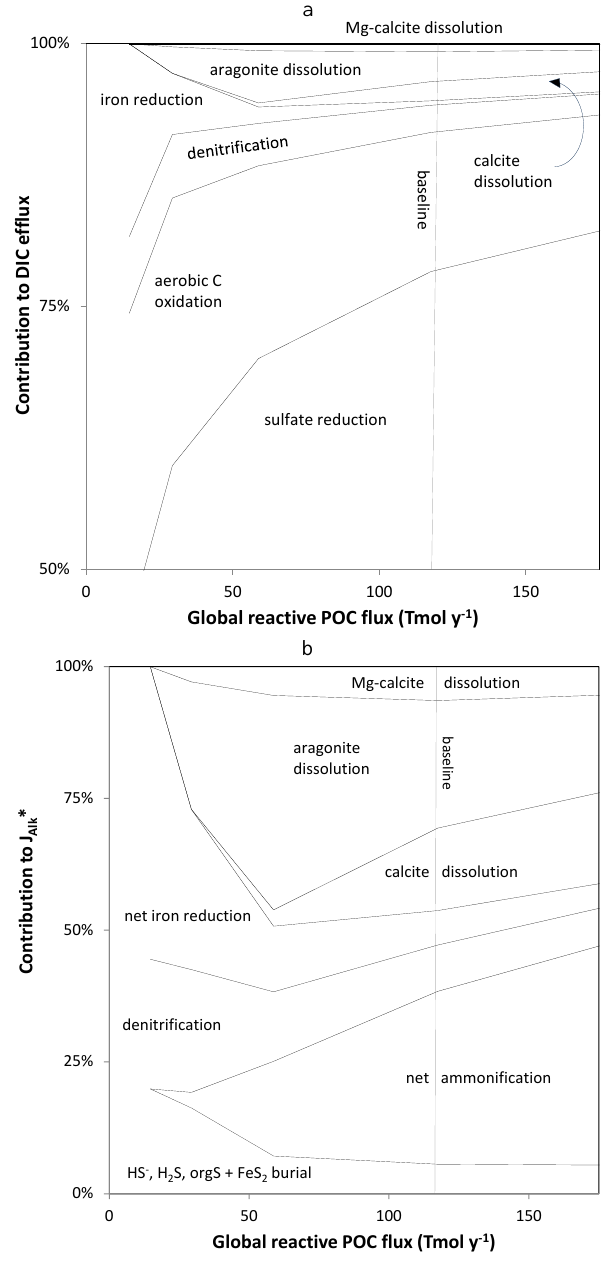
Fig. 7. Contributions of individual redox processes and PIC disso- lution to DIC efflux (a) and J Alk ∗ (b) vs. POC deposition